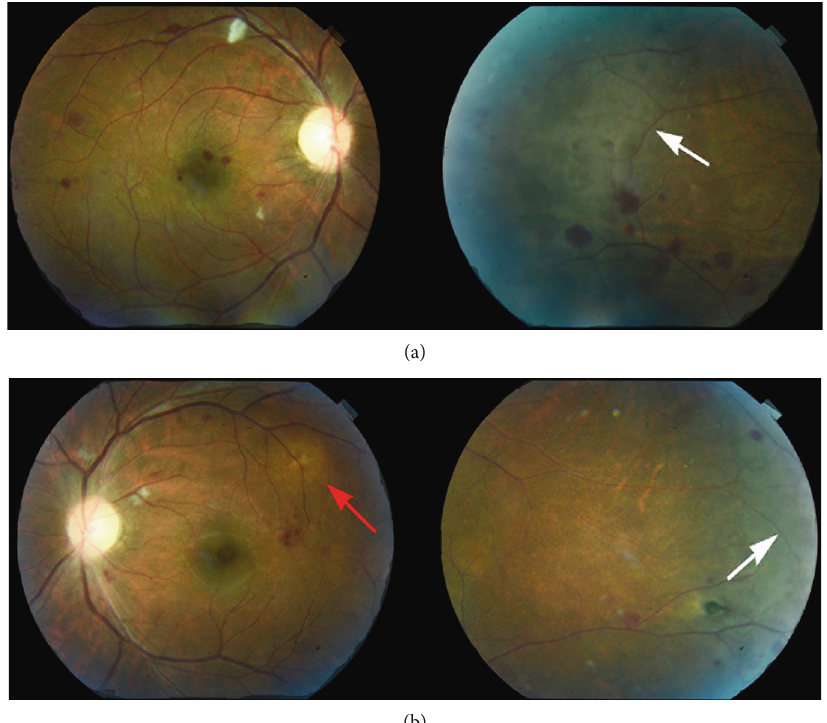
Figure 4: Case 2: fundus examination at presentation. Fundus photographs of the (a) right eye and the (b) left eye displaying multiple dot and blot hemorrhages, cotton wool spots, bilateral multiple deep yellowish lesions (red arrow), and large whitish peripheral retinal areas (white